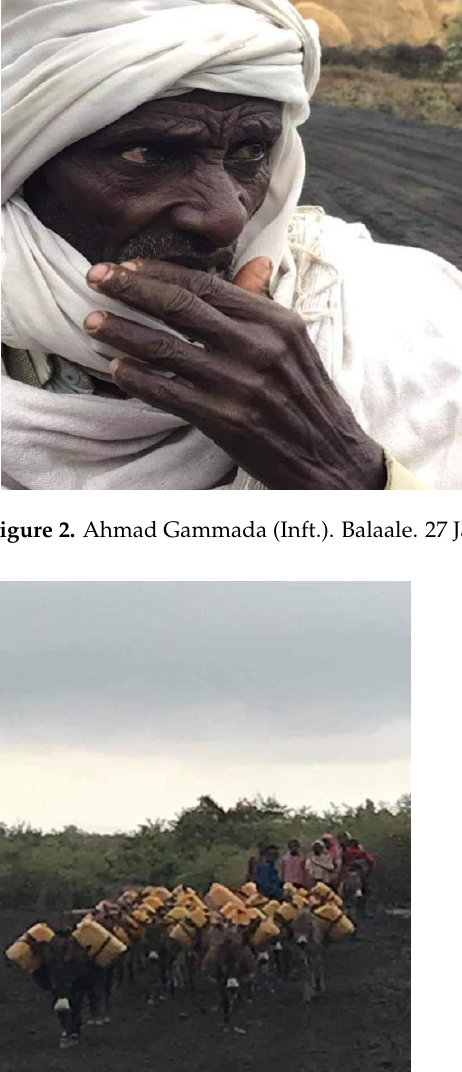
Figure 2. Ahmad Gammada (Inft.). Balaale. 27 January 2020. Photo, Author.